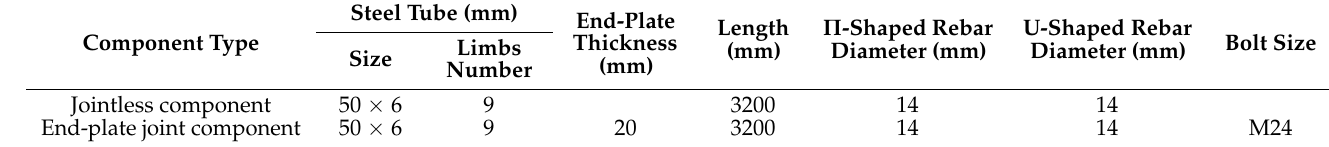
Table 1. Main structural parameters of the processed components.